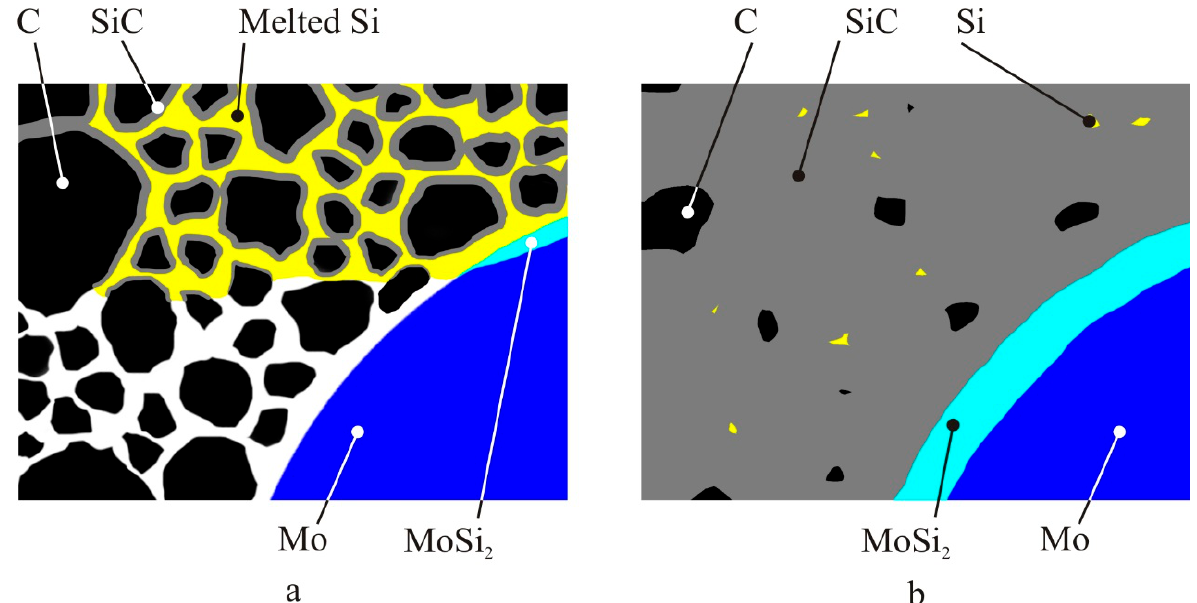
Figure 3. Scheme of the LSI process for porous carbon blanks with embedded Mo wire: ( a ) silicon impregnation process and ( b ) resulting composite structure.